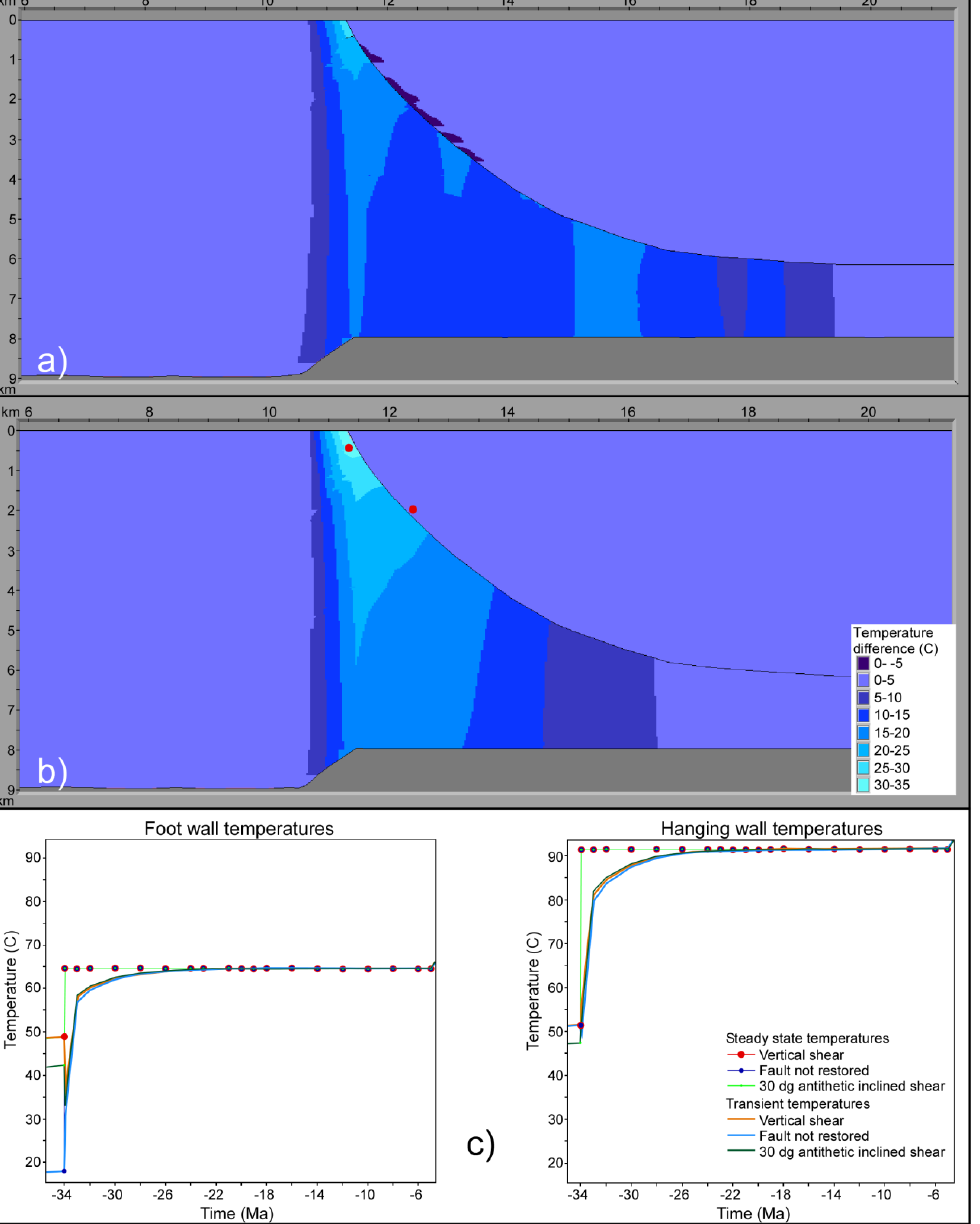
Figure 15. ( a ) Temperature difference between a scenario restored with 30 degrees antithetic inclined shear, compared to a scenario with non-restored fault. ( b ) Temperature difference for a scenario restored with vertical shear compared to a scenario with non-restored fault. ( c ) Temperature point plot from foot wall (left) and hanging wall (right) in the two points indicated in ( b ).